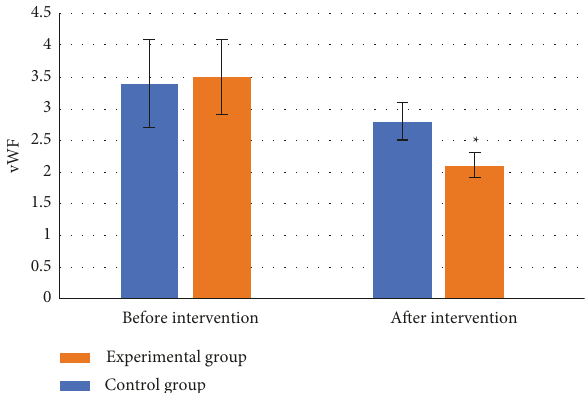
Figure 7: Comparison of vWF levels in patients’ blood. ( Note. ∗ represents a considerable difference vs. control group, P < 0 .